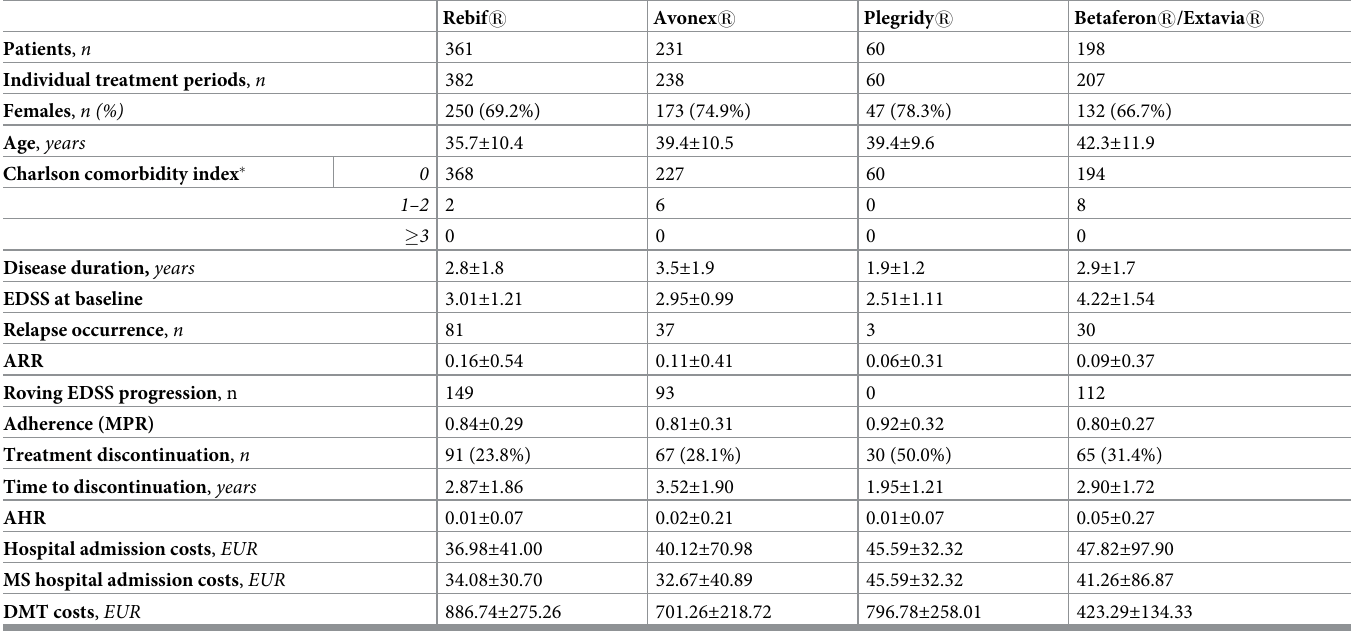
Table 1. Demographics, clinical features, persistence, adherence, healthcare resource utilization and